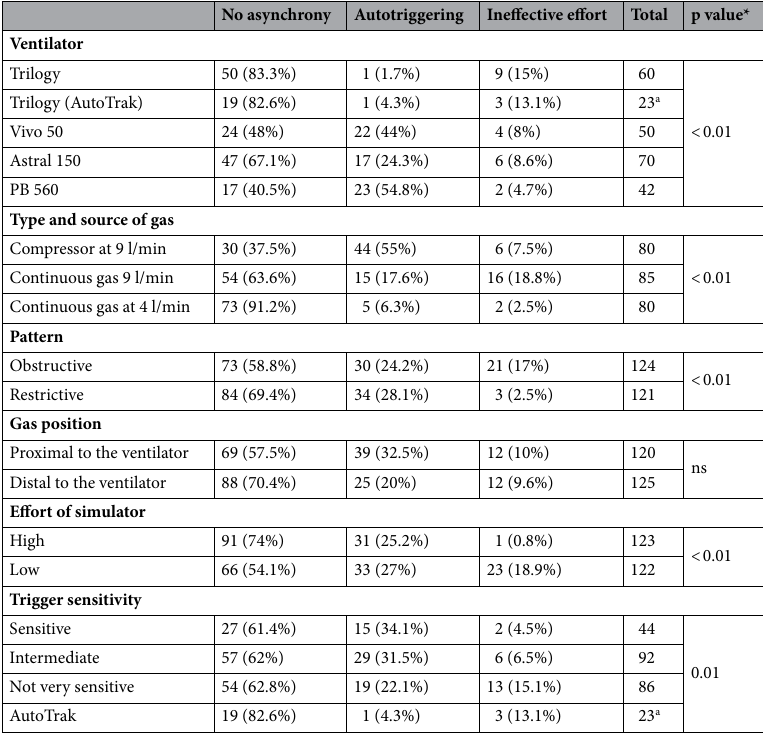
Table 3. Percentage and type of asynchronies induced by the introduction of external gas as a function of the variables controlled in a bench study model. *Chi-square test. a The number of simulations under these conditions was lower because a single level of sensitivity was used in some of the situations.